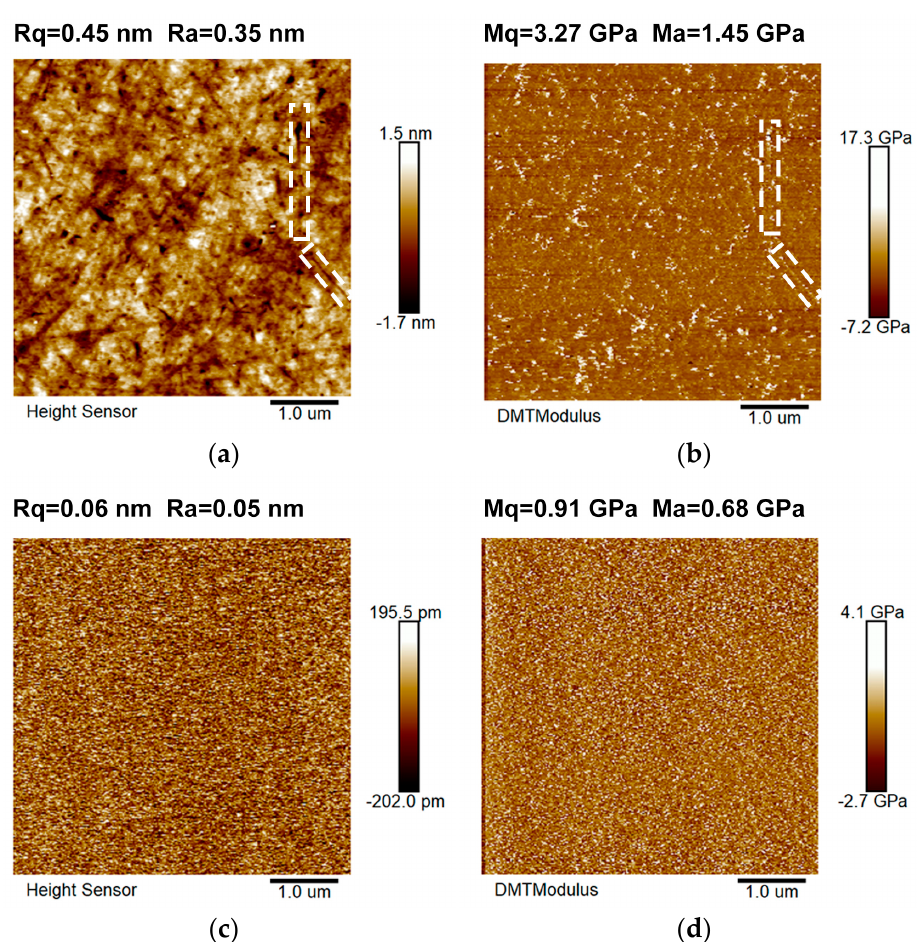
Figure 2. AFM test results. Roughly polished sample topography ( a ) and modulus ( b ); super − polished sample topography ( c ) and modulus ( d ).